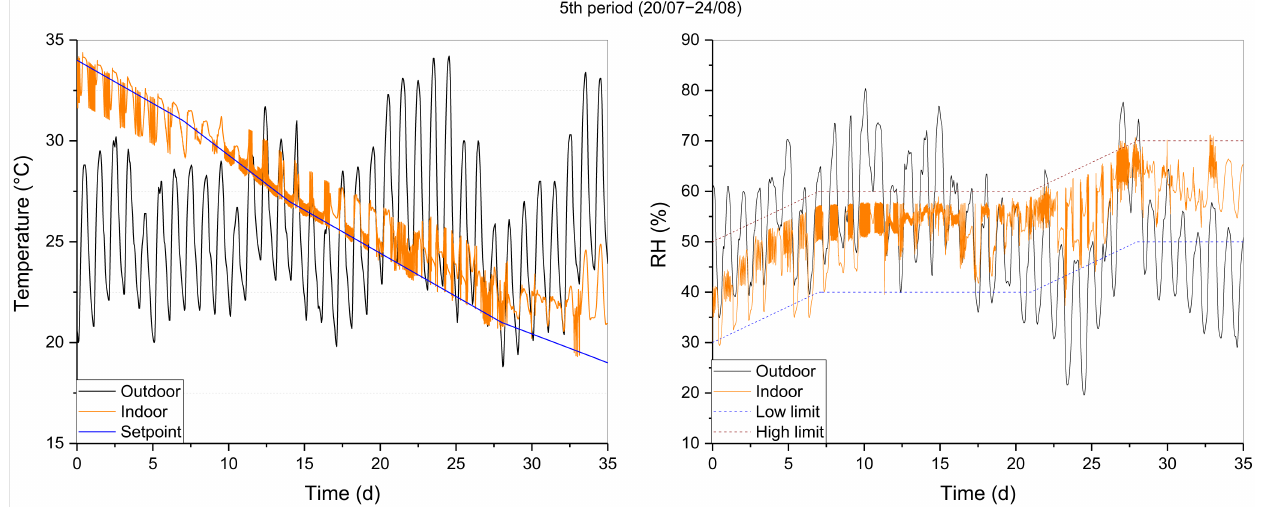
Figure 9. Temperatures and relative humidity variation during the 5th production period